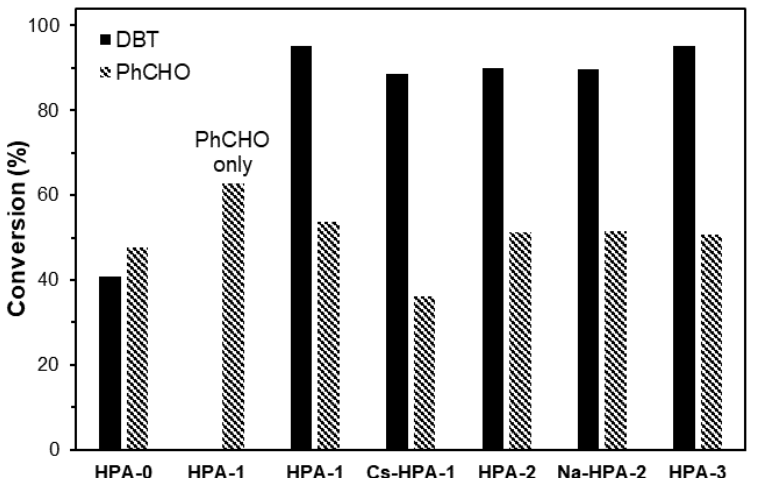
Figure 3. Effect of HPA-n catalyst (0.10 g, 0.04–0.05 mmol) on aerobic oxidation of DBT (0.40 mmol) in the presence of PhCHO (4.9 mmol) at 60 °C, 10 mL dodecane solvent, 20 mL min −1 air flow, 1300 rpm stirring speed and 2 h reaction time.